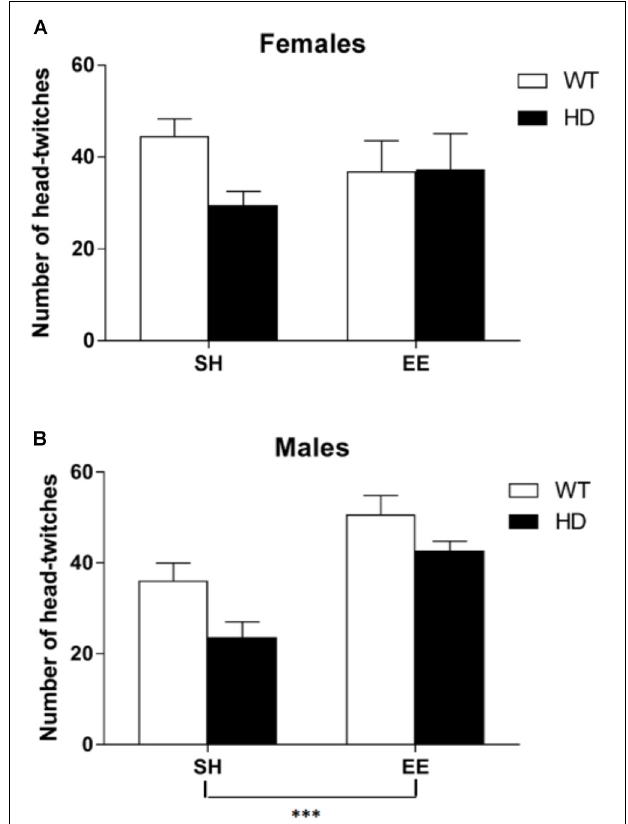
FIGURE 6 | Environmental enrichment induces a sexually dimorphic increase in the number of DOI-induced head-twitches in wild-type and HD mice at 8 weeks of age. The number of head-twitches induced by acute administration of the 5-HT 2 receptor agonist (DOI) was reduced in HD mice when compared to their wild-type counterparts ( p = 0.008). There was no overall difference between male and female mice in number of head-twitches. (A) There was no significant effect of housing conditions in female mice; n = 7–10. (B) However, there was a significant effect of housing condition ( p = 0.010) and a significant interaction between sex and housing condition ( p = 0.012) with post hoc testing showing that environmental enrichment significantly increased the number of head-twitches in both wild-type and HD male mice; n = 6–11 ( p < 0.001). Results are represented as mean ± SEM ∗∗∗ p <